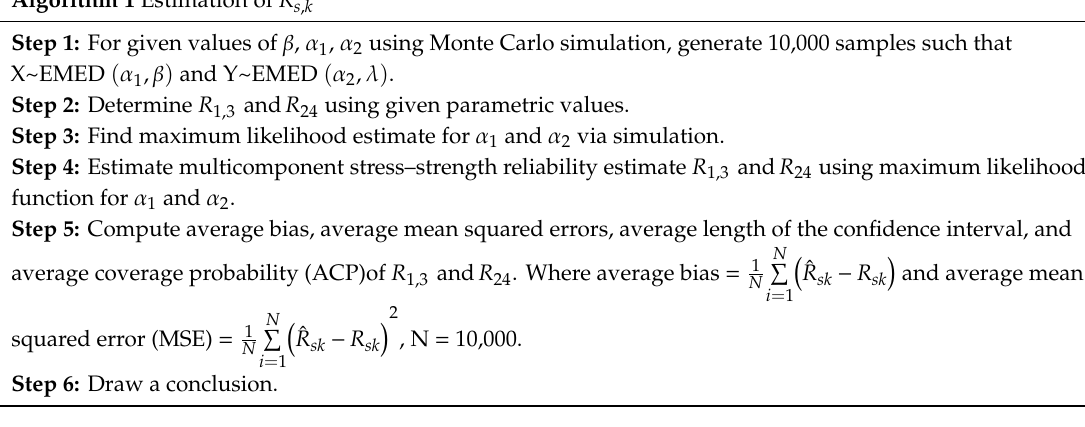
Algorithm 1 Estimation of R s ,